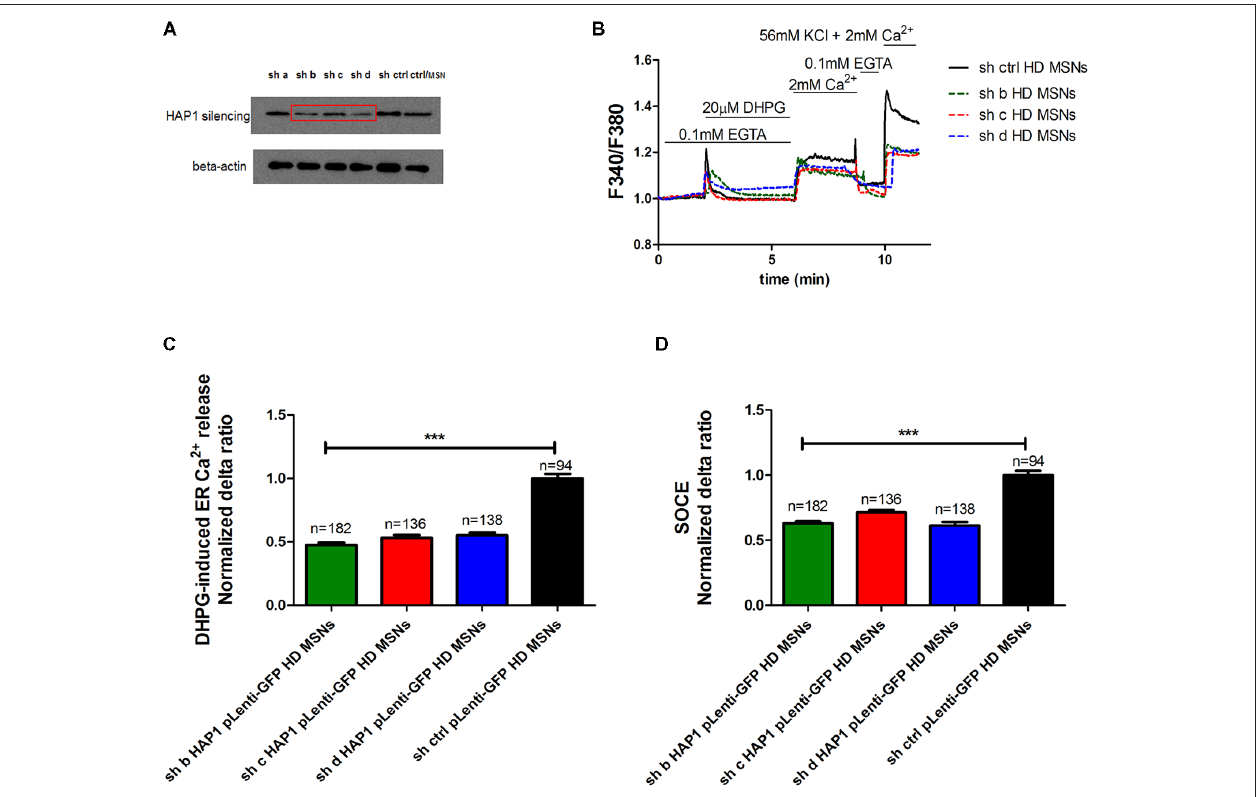
FIGURE 3 | Parameters of Ca 2 + homeostasis in YAC128 MSNs with silencing of HAP1A. (A) Immunoblots of HAP1 and beta-actin in YAC128 MSN cultures that overexpressed short-hairpin RNA (shRNA) against HAP1. shRNAs against HAP1 are named a, b, c, d, control scrambled shRNA, and control MSN cultures as indicated on the blot. (B) Protocol to induce SOCE in YAC128 MSNs with silencing of HAP1 using the eight-well system. Cultures of MSNs on DIV14 from YAC128 mice that overexpressed different shRNAs against HAP1 in pLenti-GFP were loaded with the Ca 2 + indicator Fura-2AM and incubated in Ca 2 + -free medium (0.1 mM EGTA). Ca 2 + release from the ER was induced by 20 µ M DHPG. SOCE was activated by the addition of 2 mM Ca 2 + to the medium. KCl (56 nM) in 2 mM Ca 2 + was applied to distinguish neurons from glial cells. (C) Ca 2 + release from the ER in YAC128 MSNs that overexpressed different shRNAs against